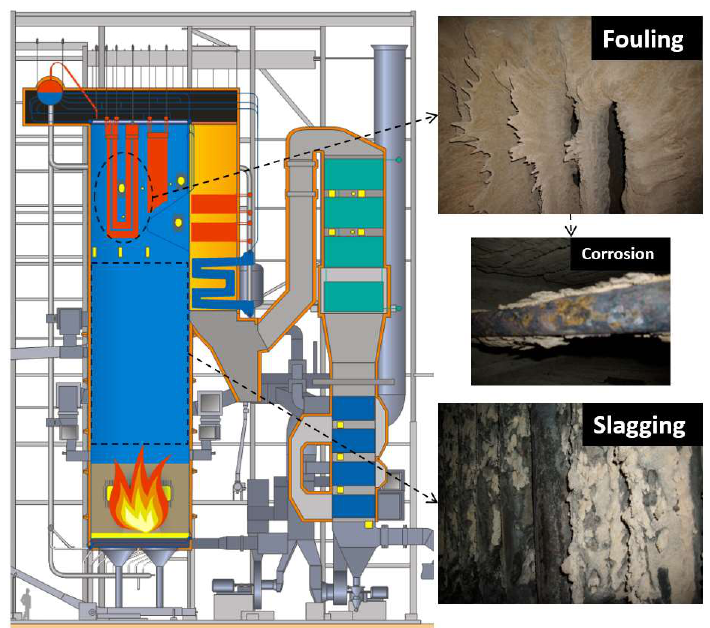
Figure 1. Schematic diagram of a boiler with magnified images showing ash-related problems— slagging, fouling, and corrosion—on the surfaces of furnace walls and superheater tubes.